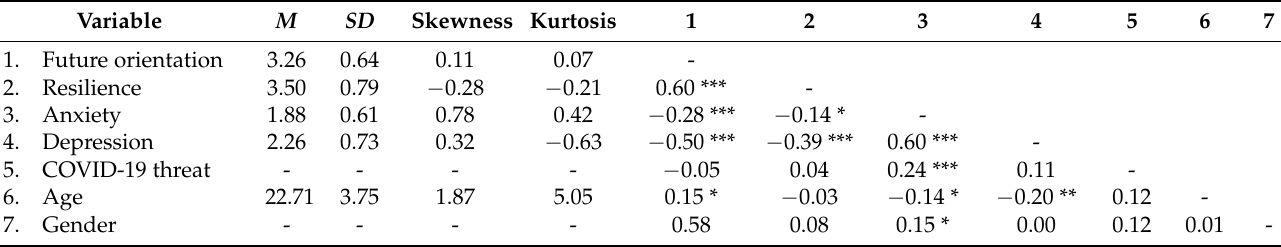
Table 1. Descriptive statistics and